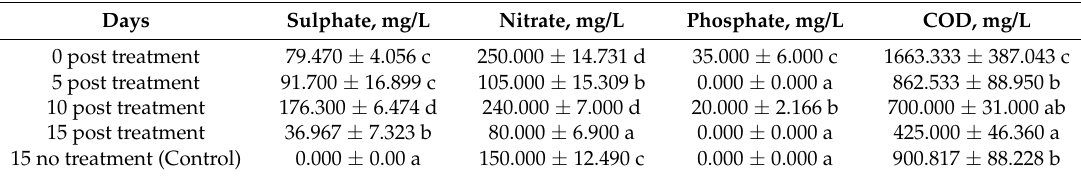
Table 3. Chemical Oxygen demand (COD) and some Anion concentration of cassava mill effluents treated with S. cerevisiae